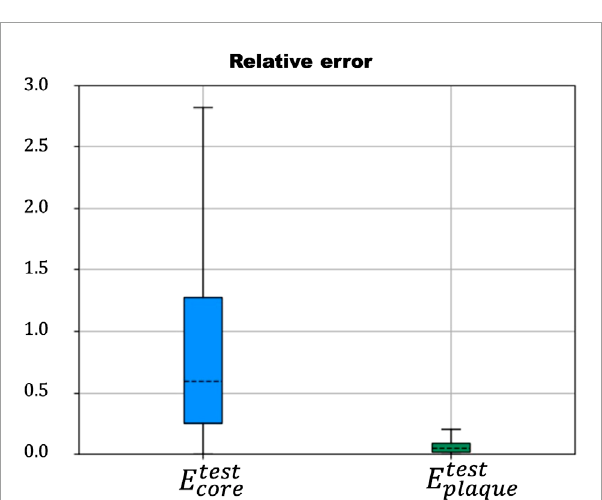
FIGURE 7 Relative error in the prediction of E core (blue) and E plaque (green) using the transfer-learned ANN with the realistic database.